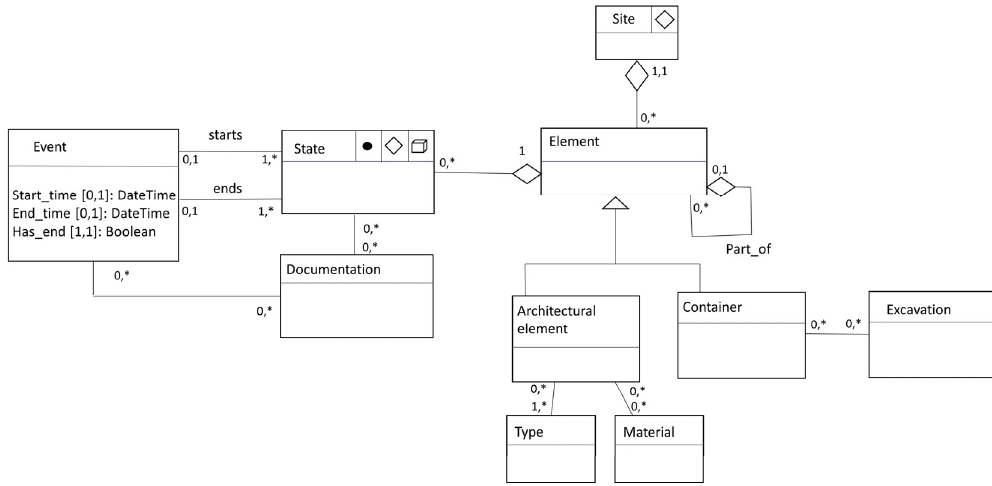
Figure 9. Data Model of the Coudenberg Palace IS.